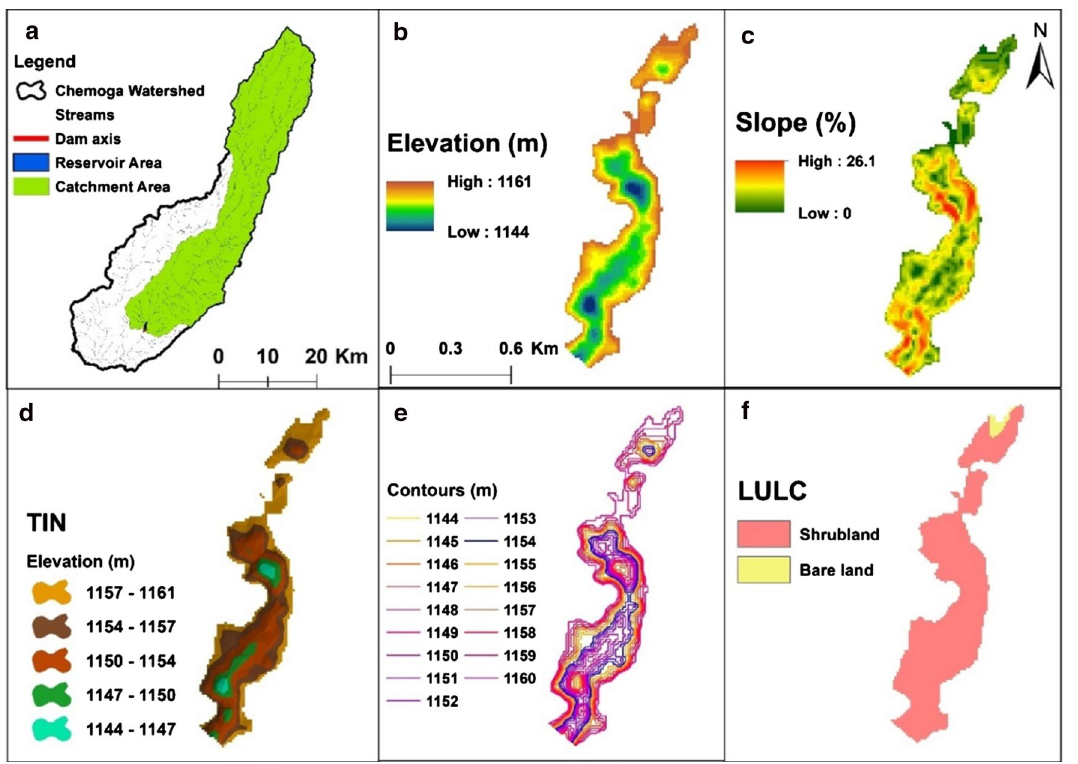
Fig. 20 Evaluation parameters for proposed Dam site 5: a Catchment area, b DEM, c slope, d triangulated irregular network (TIN), e contours, f